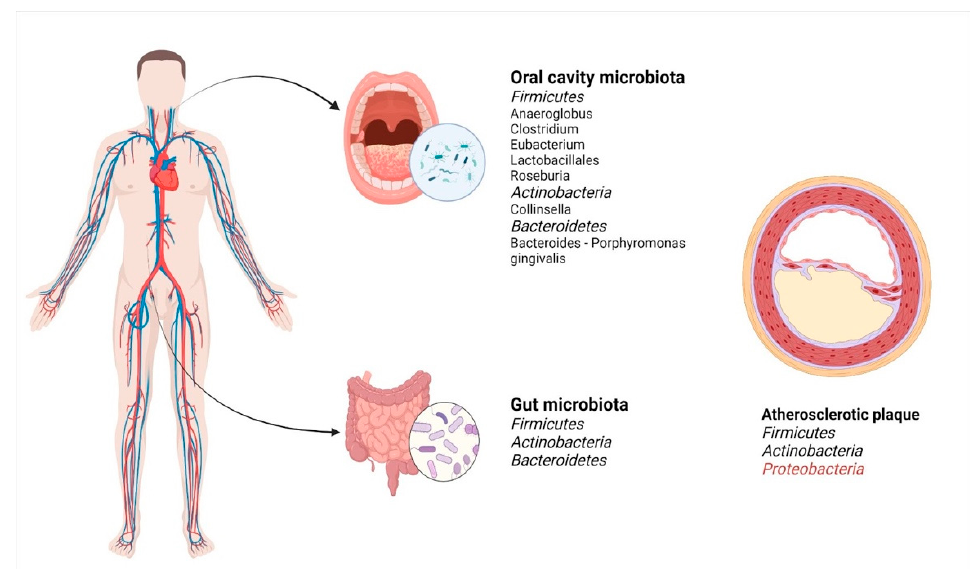
Figure 2. Main bacterial phyla found in atherosclerotic plaque. Bacterial analysis from atherosclerotic plaque samples proved the existence of microorganisms common with the gut microbiota or oral cavity microbiota. The oral cavity and the gut are dominated by Firmicutes , while atherosclerotic plaques are rich in Proteobacteria . The Bacteroidetes phylum is very well represented in the gut but is present to a lesser extent in atherosclerotic plaques. The ratio of Firmicutes/Bacteroidetes is demonstrated to be higher in patients suffering from coronary artery disease. Created with BioRender.com (Last accessed on 21 July